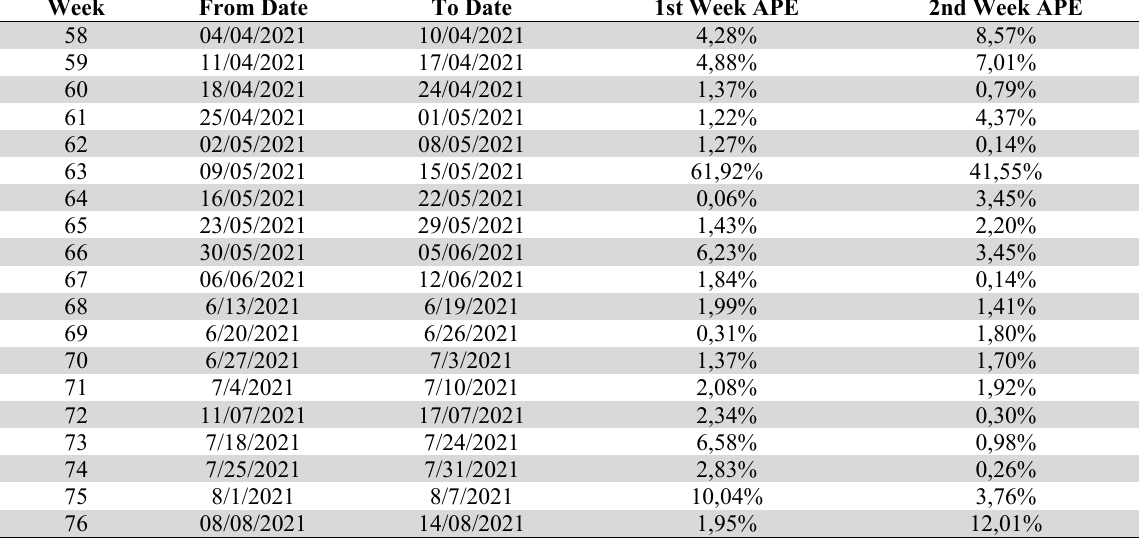
Fig. 8. Result of MLP forecast data and actual COVID-19 cases in West Java. Absolute percentage error COVID-19 weekly new case forecast